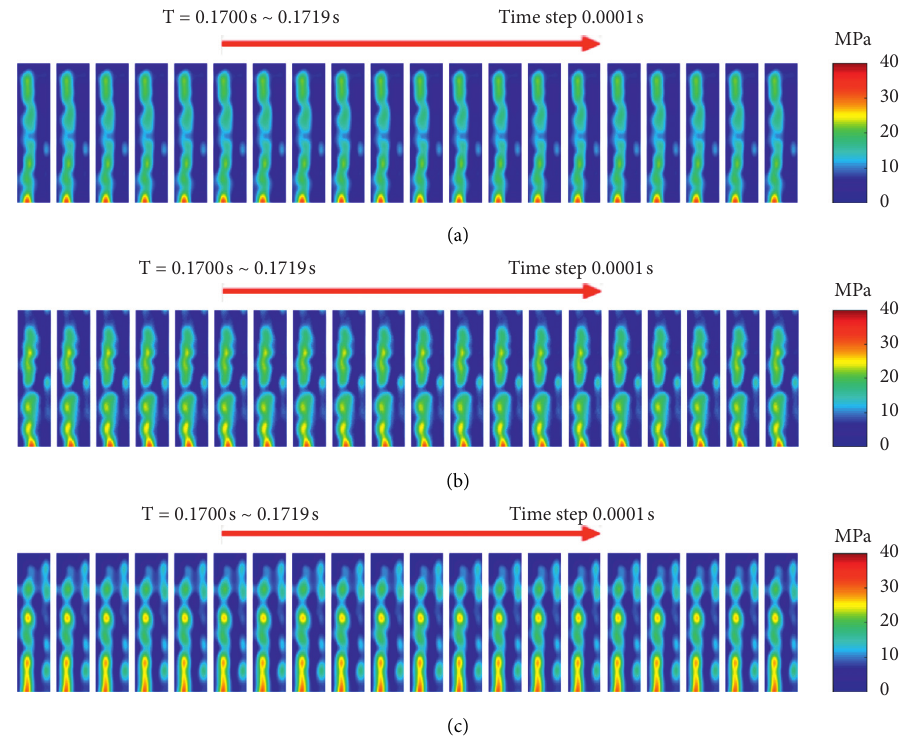
Figure 13: Phase II: Real-time stress distribution of the contact area on axle spline surface under different loading cases. (a) Real-time stress status under 0.3 m/s2 driving rate, #10 tooth. (b) Real-time stress status under 0.5 m/s2 driving rate, #10 tooth. (c) Real-time stress status under 1 m/s2 driving rate, #10